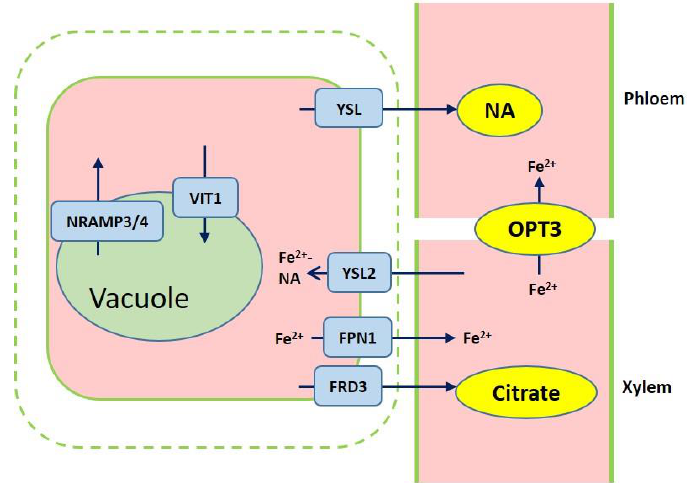
Figure 2. Overview of iron transport from roots to shoots. Ferric reductase defective 3 (FRD3) and ferroportin1 (FPN1) are responsible for importing citrate and iron into the xylem. Iron chelation with citrate or NA are translocated to shoots. Yellow stripe-like 2 (YSL2) contributes to the Fe 2+ -NA distribution from the xylem to neighboring cells. Iron is loaded into vacuole through VIT1, while iron efflux of vacuolar occurs via NRAMP3 and NRAMP4. OPT3 mediates the Fe transport to sink tissues via the phloem.